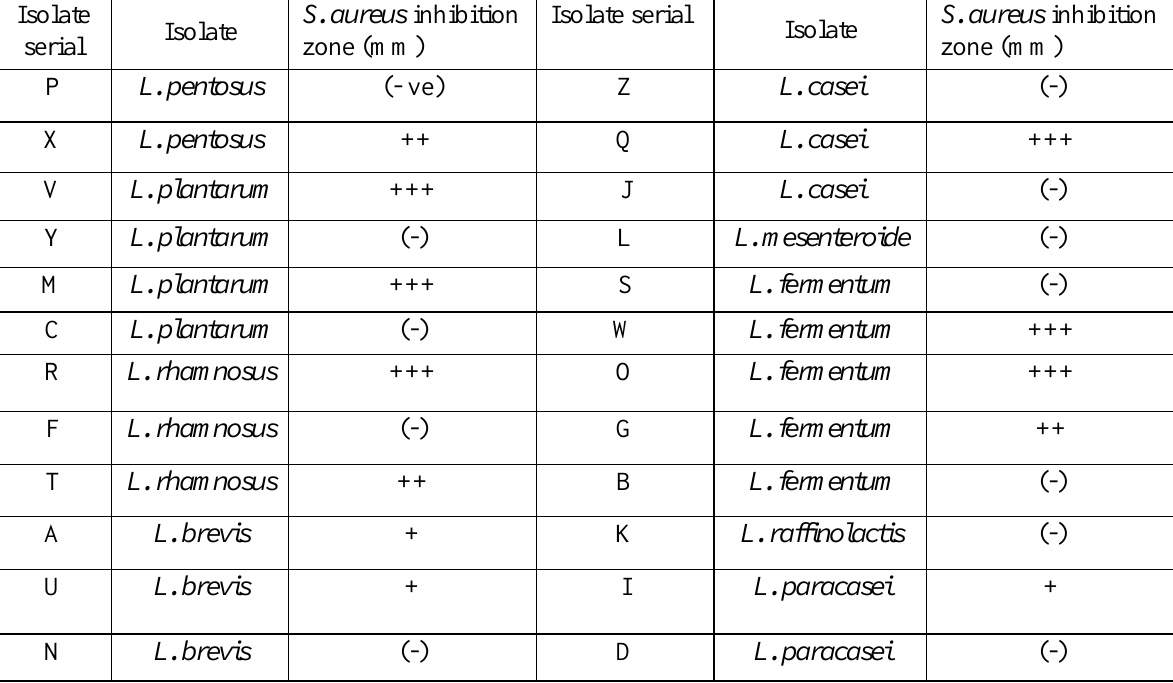
Table 3: Agar well diffusion assay, results represent the mean ± standard deviation of three replicates. Isolate